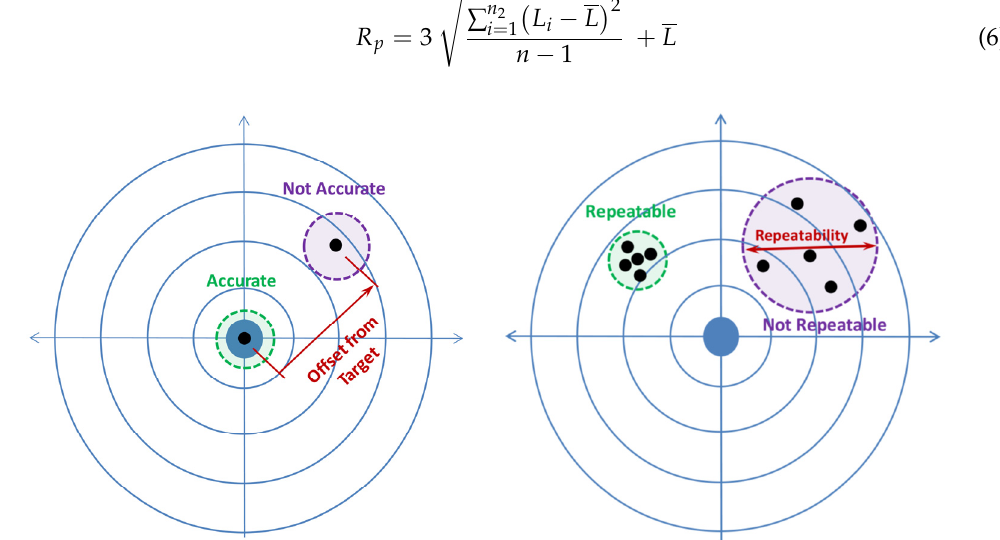
Figure 4. Accurate and non-accurate comparison ( left ), and repeatable and non-repeatable compari- son ( right ). Table 1. Target position tested for accuracy and repeatability test. Position No.